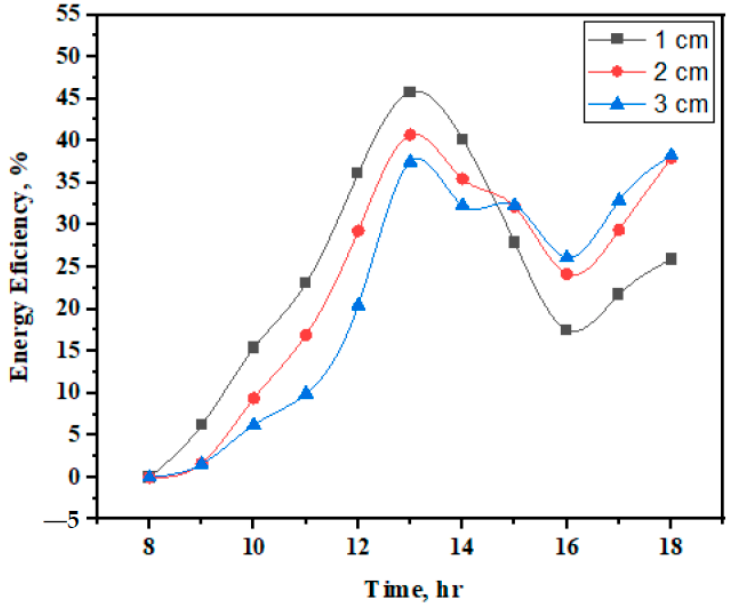
Figure 9. Energy efficiency with respect to time. Table 2. Comparison with similar distillation systems.